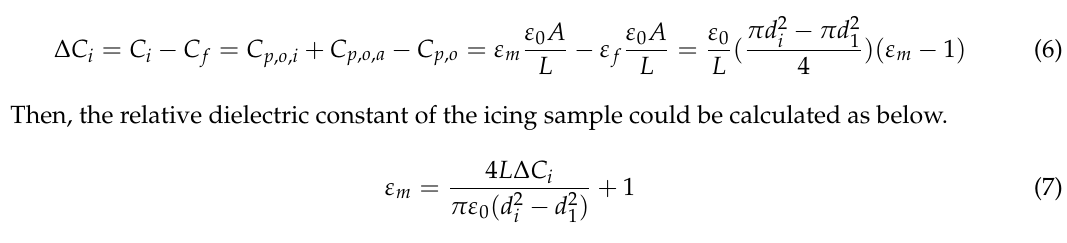
Figure 5. The equivalent circuit of the capacitive sensor, before and after icing accumulation: ( a ) The equivalent circuit before icing accumulation; ( b ) the equivalent circuit after icing accumulation.